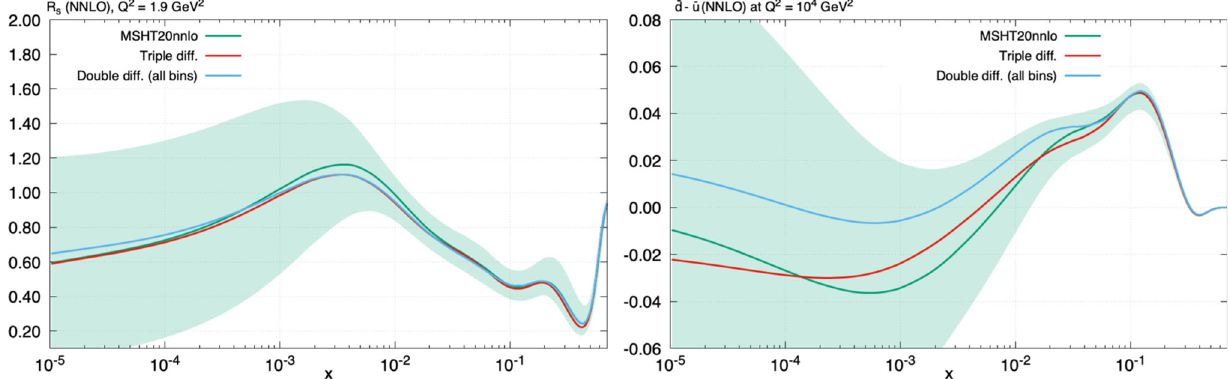
Fig. 68 The strangeness ratio, R s at Q 2 = 1 . 9 GeV 2 , and d − u , at Q 2 = 10 4 GeV 2 for variants of the MSHT NNLO fits ( α S free). Results with the ATLAS 8 TeV double differential data replaced by the